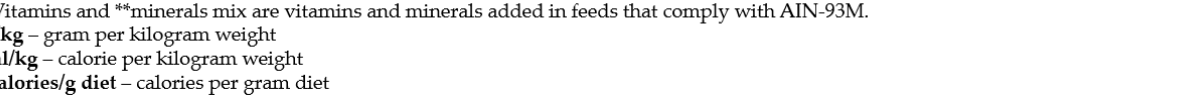
Figure 2. Composition of experimental diets (g per kg of feed).